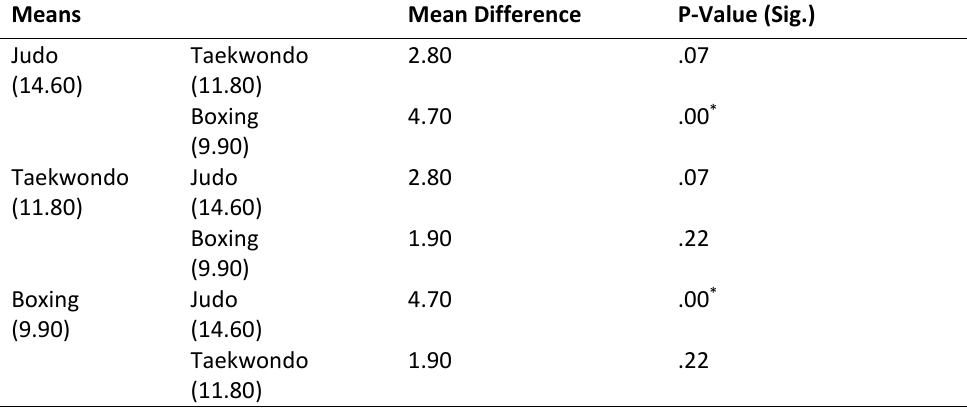
Table 13. Analysis of least significant difference (LSD) post-hoc test among judo, taekwondo and boxing players on the sub-parameter team ritual